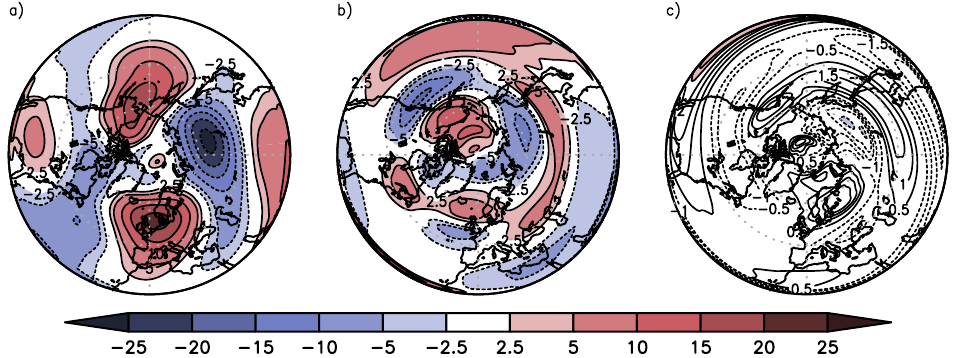
Figure 9. Different contributions of the calculated trend-like pattern of the zonally asymmetric total column ozone in [DU/decade] during the healing stage (2012/2016–2002/2006): ( a ) ClimEta, ( b ) ClimWav, and ( c ) ANO. Only contributions of wave 1–4 are